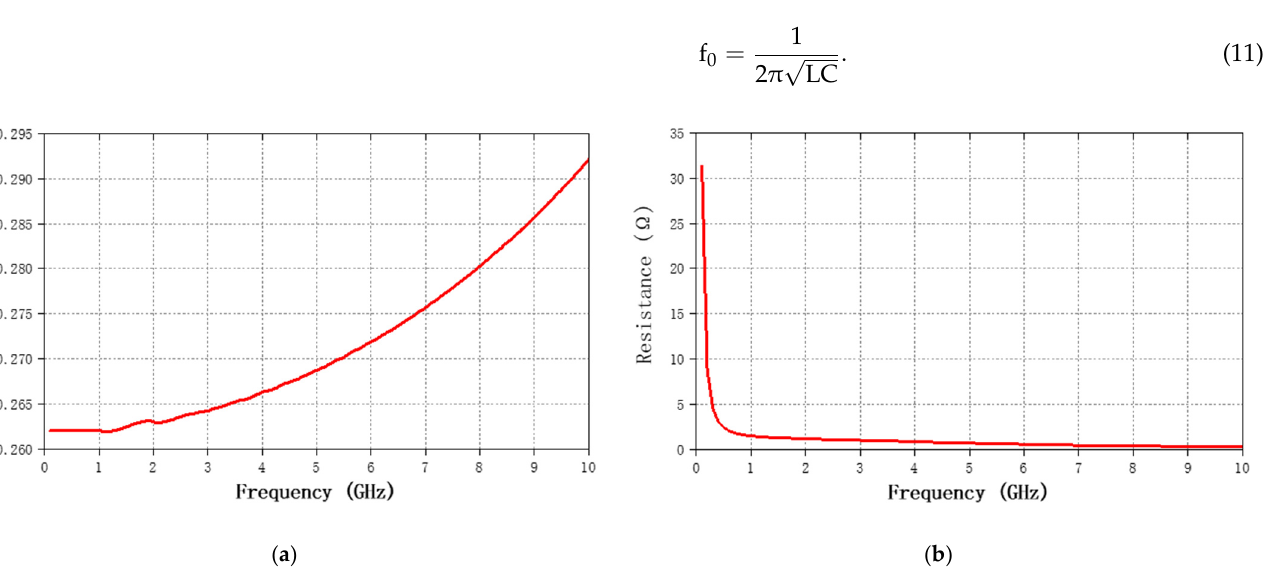
Figure 6. Simulation results of the capacitance and resistance for optimization: ( a ) Simulated capacitance value; ( b ) Simulated resistance value.